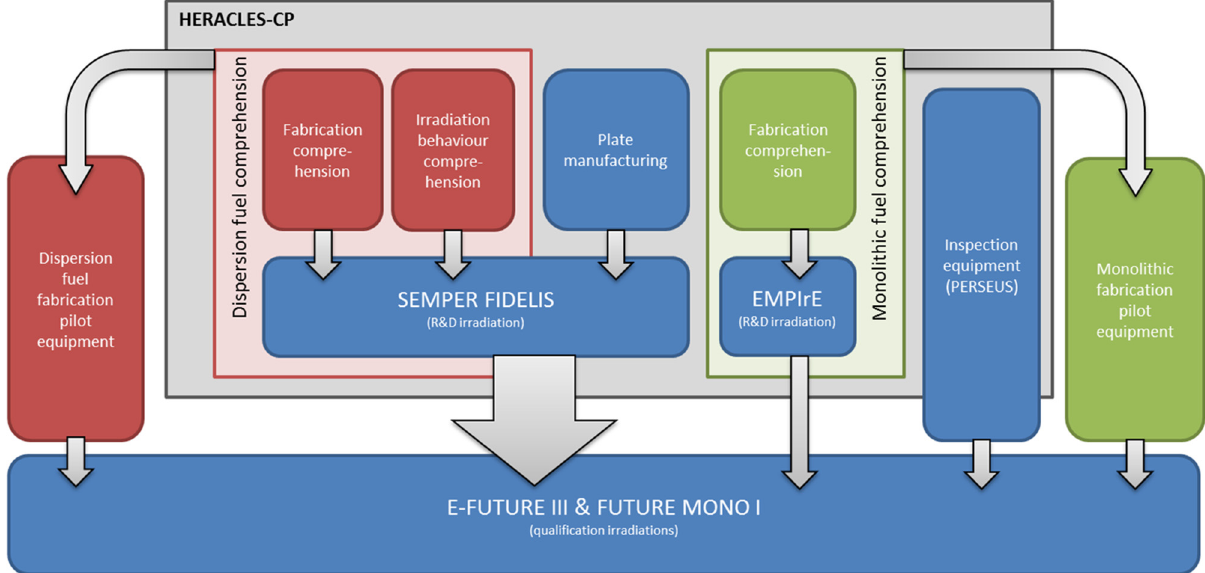
Fig. 1. Flow chart of the HERACLES-CP